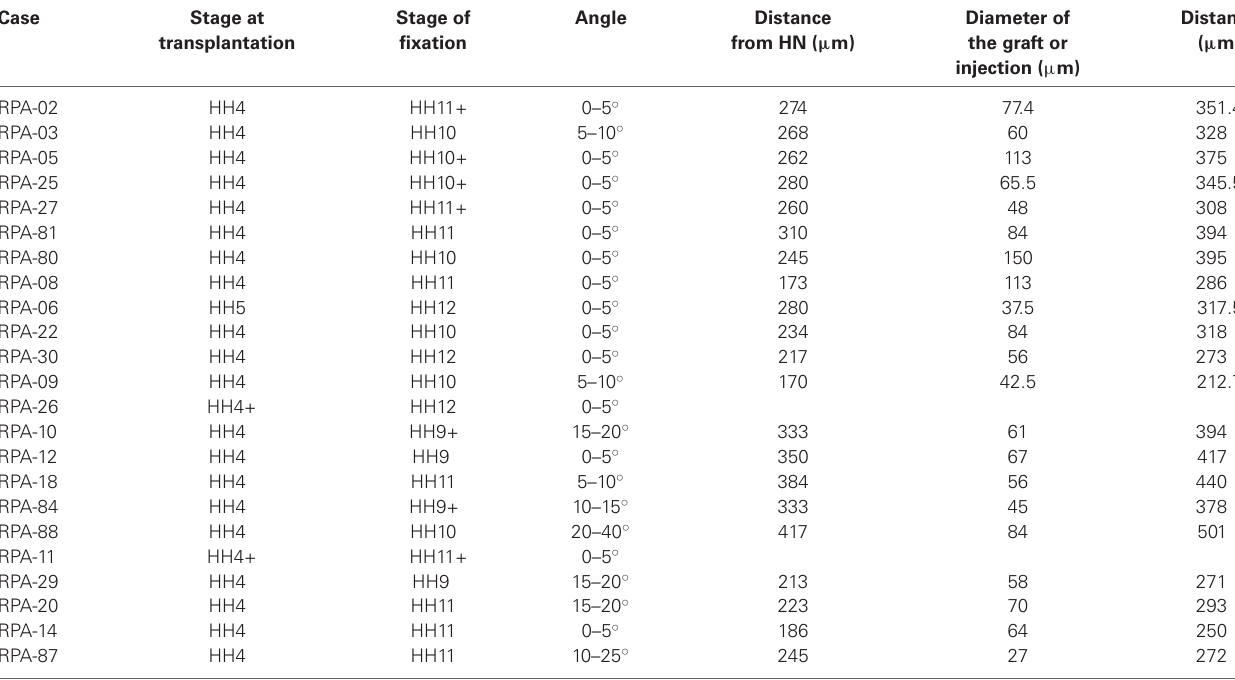
Table 1 | Measurements of the experimental cases, data taken at HH4/5